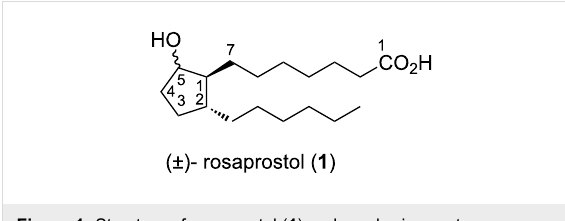
Figure 1: Structure of rosaprostol ( 1 ) and numbering system.